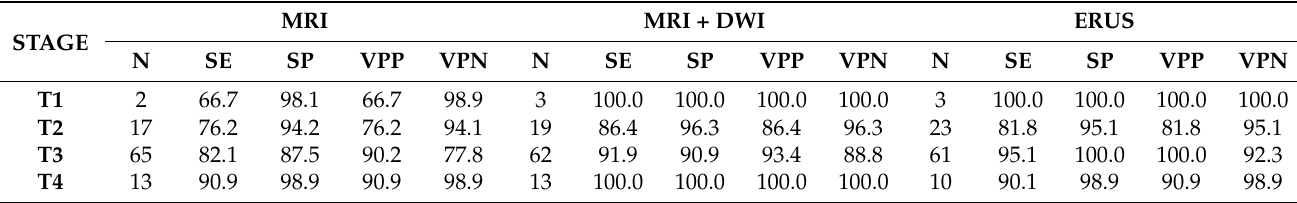
Table 2. Diagnostic performance of MRI, DWI, and ERUS for each tumor stage were evaluated considering the post-surgical results as the gold standard (CI: 95%).